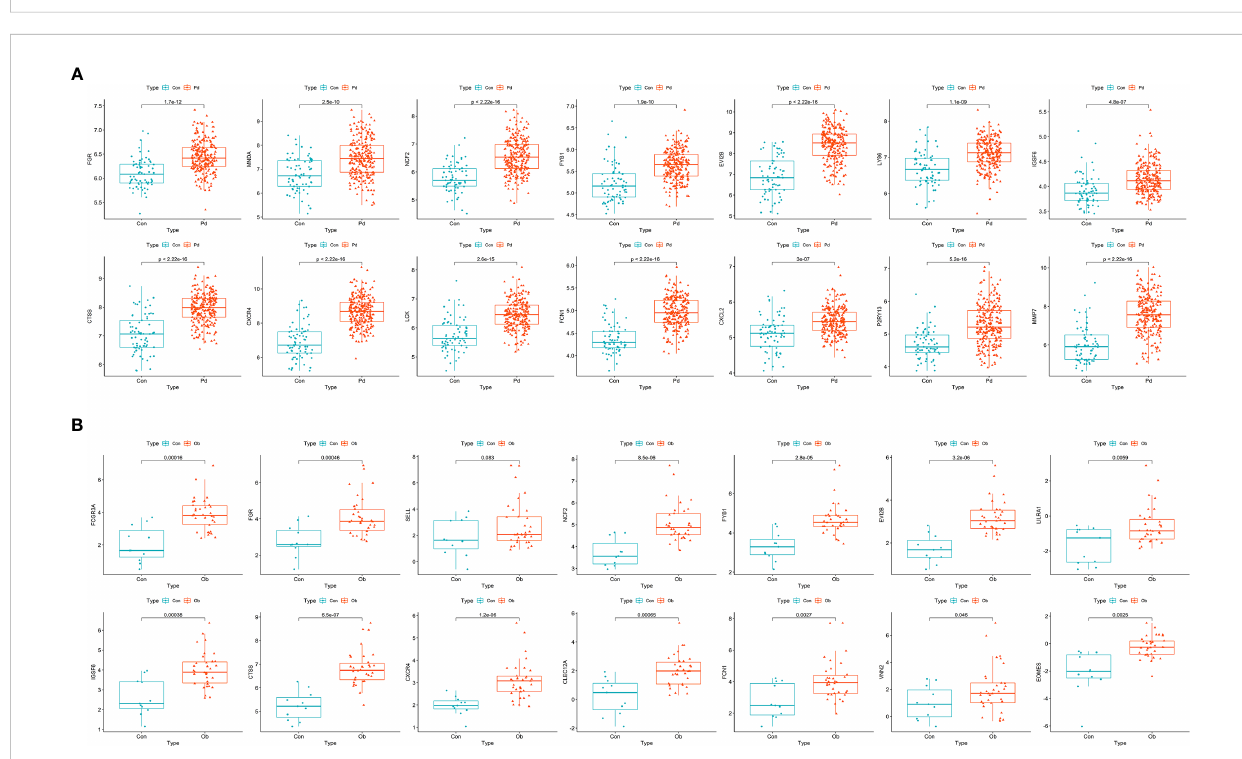
FIGURE 4 Identi fi cation and validation of hub genes. (A) Boxplots of the expression levels of hub genes in GSE152991. The expression levels of the 14 hub genes are signi fi cantly higher in the obesity group. (B) Boxplots of the expression levels of hub genes in GSE16134. The expression levels of the 14 hub genes are signi fi cantly higher in the periodontitis group. A p -value < 0.05 was considered statistically signi fi